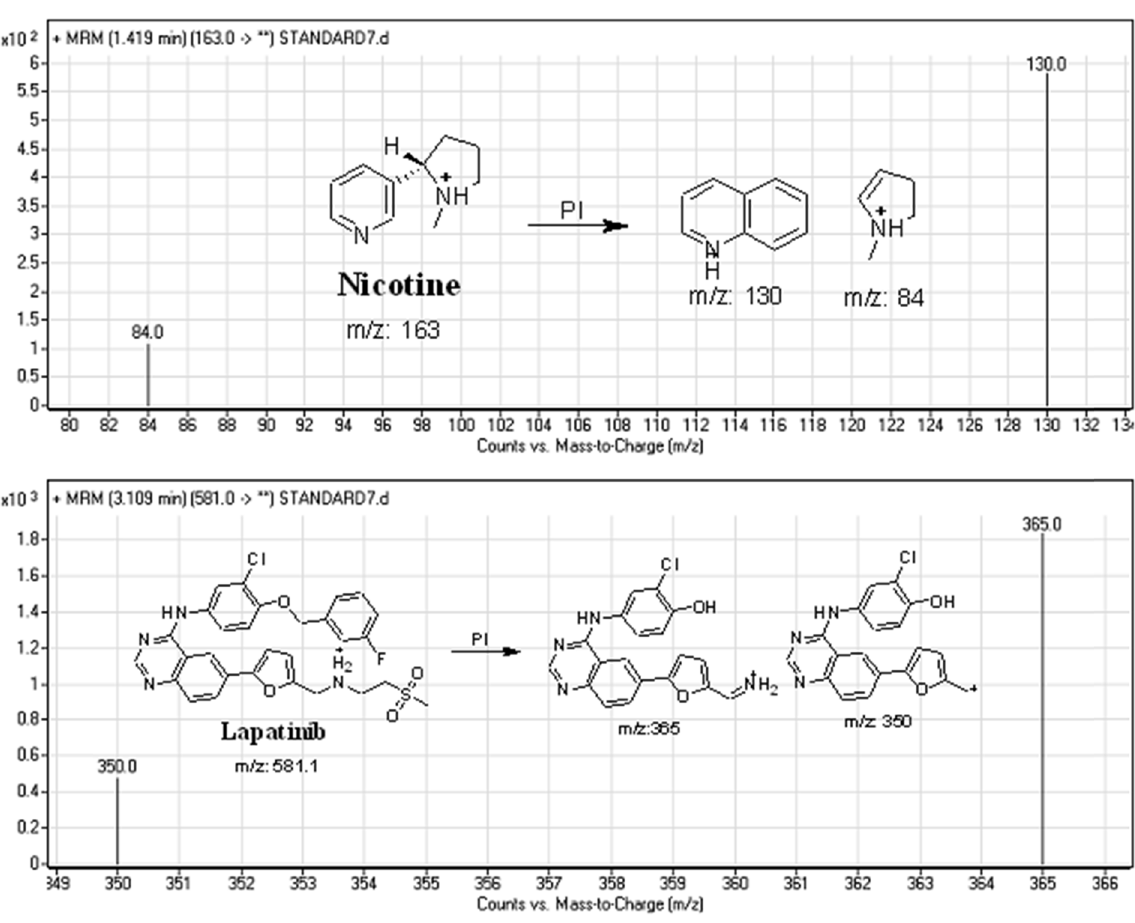
Figure 3: The MS/MS spectra of NT and lapatinib ( IS ) in positive mode.